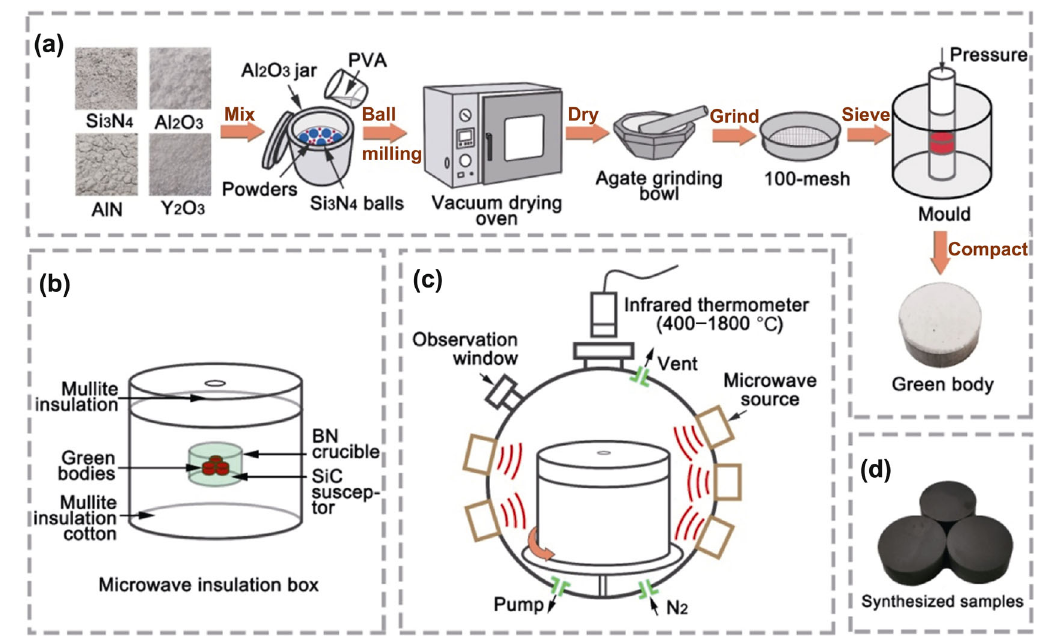
Fig. 1 (a) Preparation process of green body, (b) diagrammatic sketch of the microwave insulation box, (c) diagrammatic sketch of the microwave synthesis system, and (d) microwave-synthesized α / β -SiAlON cutting